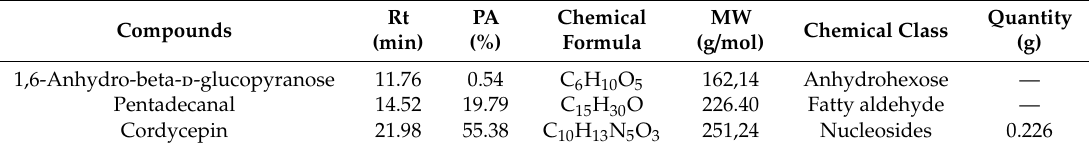
Table 4. Identification and quantification of CM4 fraction by GC-MS.